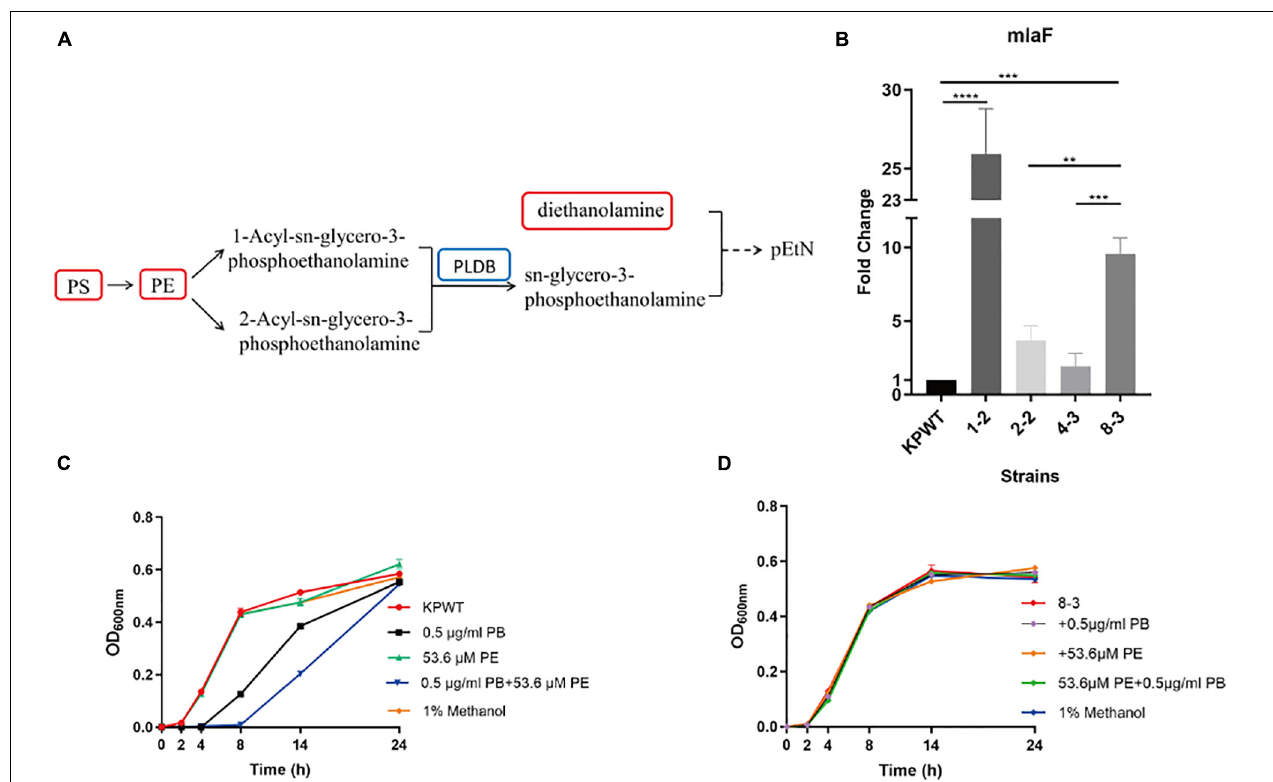
FIGURE 7 | Alterations in phospholipid metabolism and transport in polymyxin B (PB) resistant Klebsiella pneumoniae , and effect of phosphatidylethanolamine (PE) on the activity of PB against K. pneumoniae . (A) Perturbation in glycerophospholipid metabolism. Red box in the flow charts represents the significantly increased metabolites, while blue box indicates the significantly decreased protein. Components without box mean that no differential expression occurs between PB-resistant and -susceptible K. pneumoniae . (B) Changes in the transcription level of mlaF during induction of KPWT. (C) and (D) Affection of 0.5 µ g/ml PB alone or combined with 53.6 µ M PE on the growth of KPWT and strain 8-3. Data represent the means ± SD of three independent repeated experiments. ** P < 0.01; *** P < 0.001; **** P <